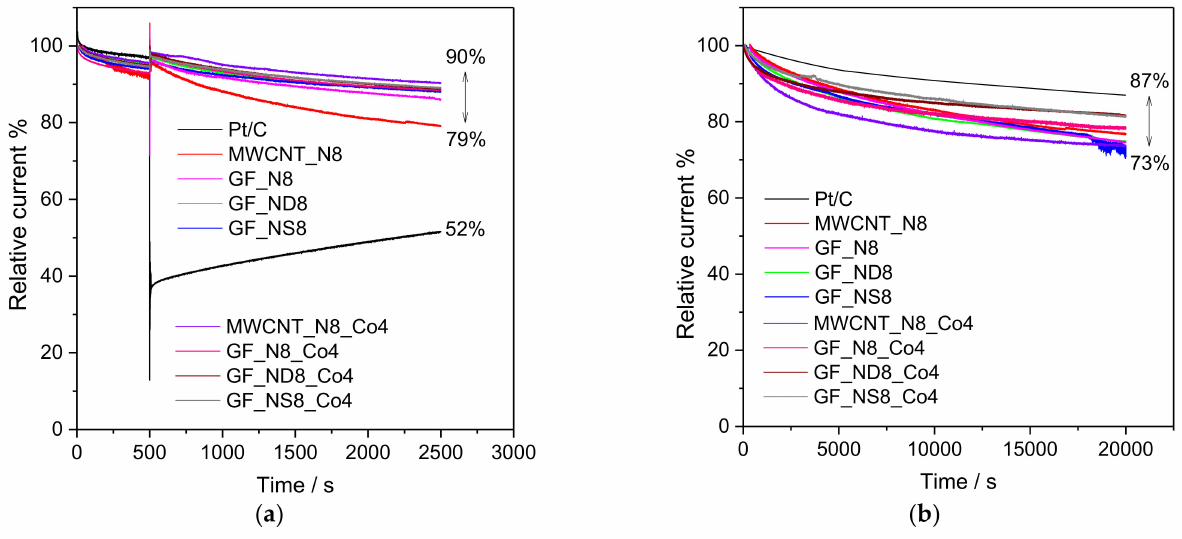
Figure 9. Chronoamperometric responses of the prepared electrocatalysts with the addition of 0.5 mol dm − 3 methanol after ≈ 500 s, at E = 0.46 V vs. RHE, at 1600 rpm, in 0.1 mol dm − 3 O 2 -saturated KOH ( a ); Chronoamperometric responses at E = 0.46 V vs. RHE, at 1600 rpm, in 0.1 mol dm − 3 O 2 -saturated KOH for 20,000 s ( b